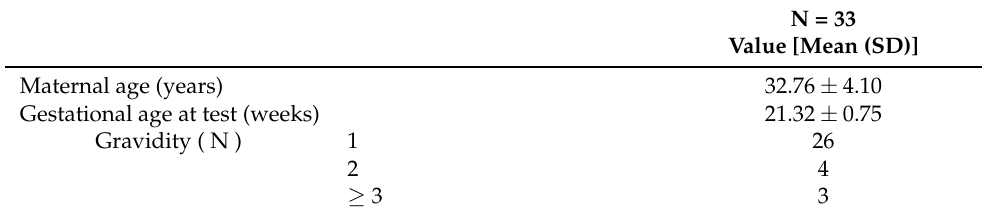
Table 3. Demographics of the study population.